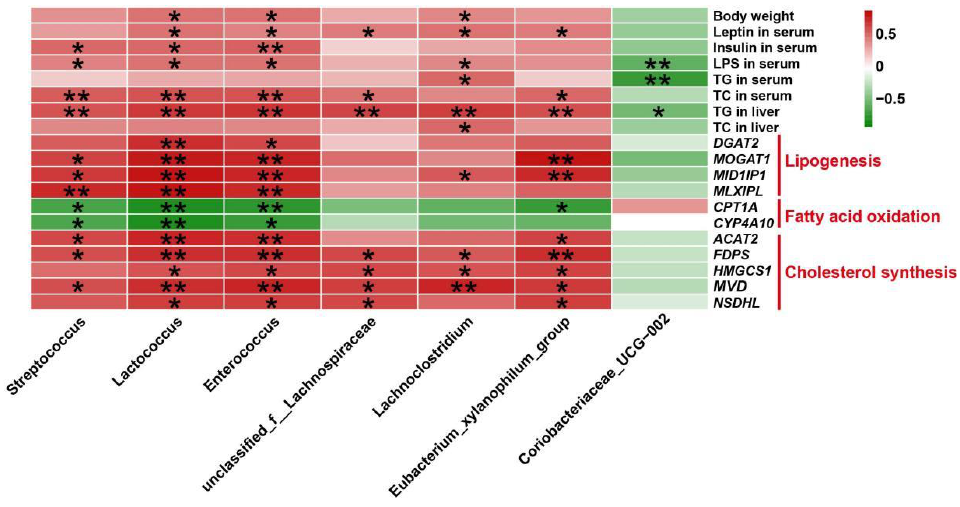
Figure 10. Pearson’s correlation analysis between fecal microbiota at the genus level and lipid metabolic indexes. * p < 0.05 and ** p < 0.01 represents significantly positive (red) or negative (green) correlation.